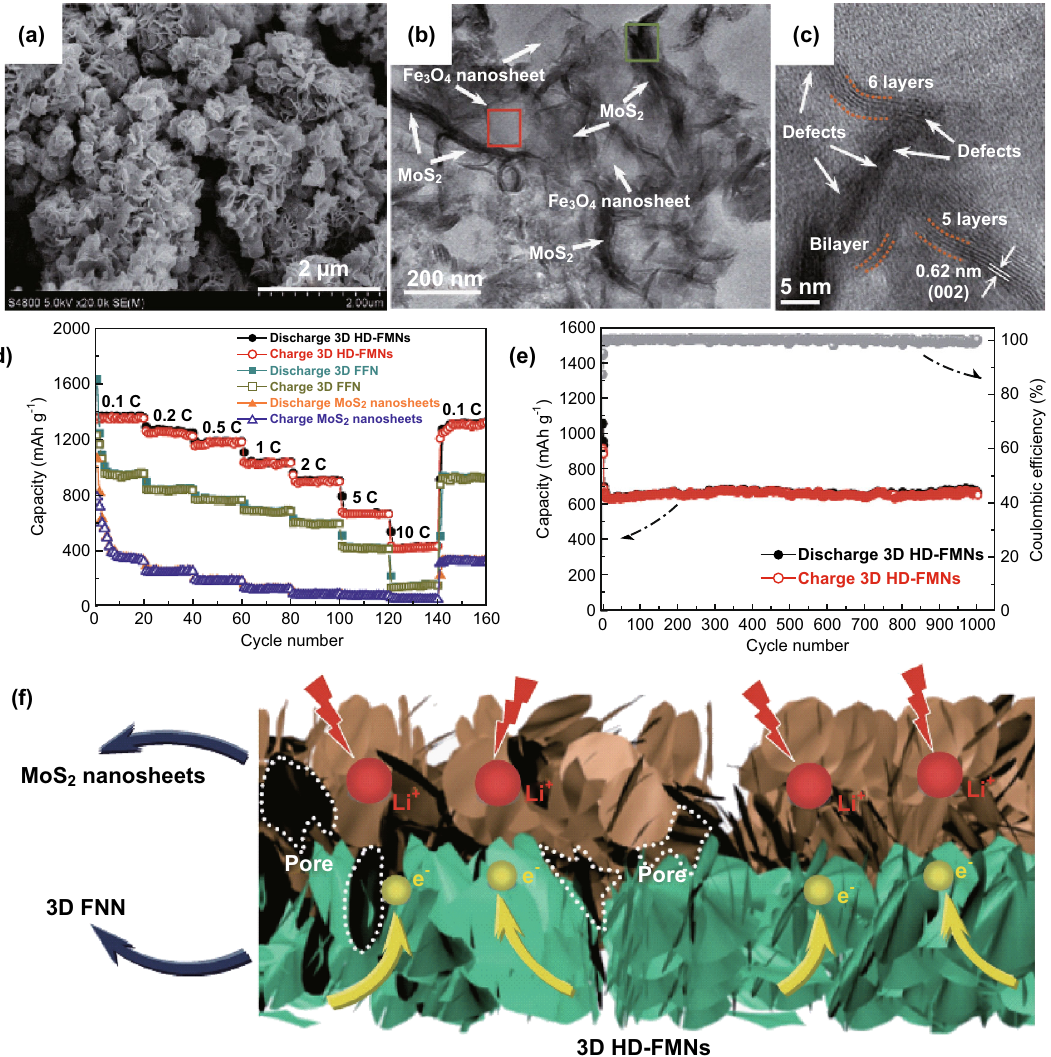
Fig. 8 3D architectures based on 2D Fe 3 O 4 /MoS 2 nanoflakes for LIBs. a SEM and b TEM image of 3D hierarchical dual Fe 3 O 4 /MoS 2 nanoflakes. c HRTEM image of the MoS 2 nanoflakes in 3D hierarchical dual Fe 3 O 4 /MoS 2 nanoflakes. d Rate performance of MoS 2 nanoflakes, 3D Fe 3 O 4 /MoS 2 nanoflakes, and 3D hierarchical dual Fe 3 O 4 /MoS 2 electrodes at various current rates. e Long-life cycling performance of 3D hierarchical dual Fe 3 O 4 /MoS 2 nanoflake electrode at 5 C for 1000 cycles. Reproduced with permission [103]. Copyright (cid:2) 2017, John Wiley & Sons,